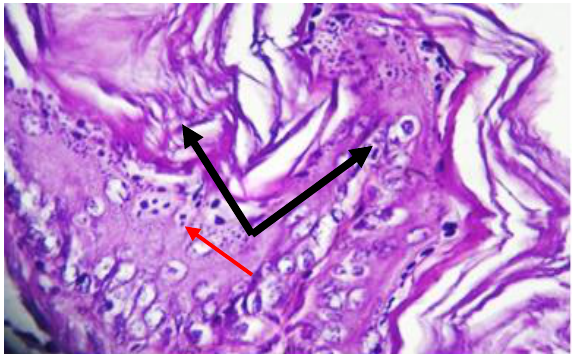
Figure,6: Section in the skin of infected non- immunized animal at day 30 post challenge showed sever dilation and degeneration of hair follicles (H&E stain 400X).